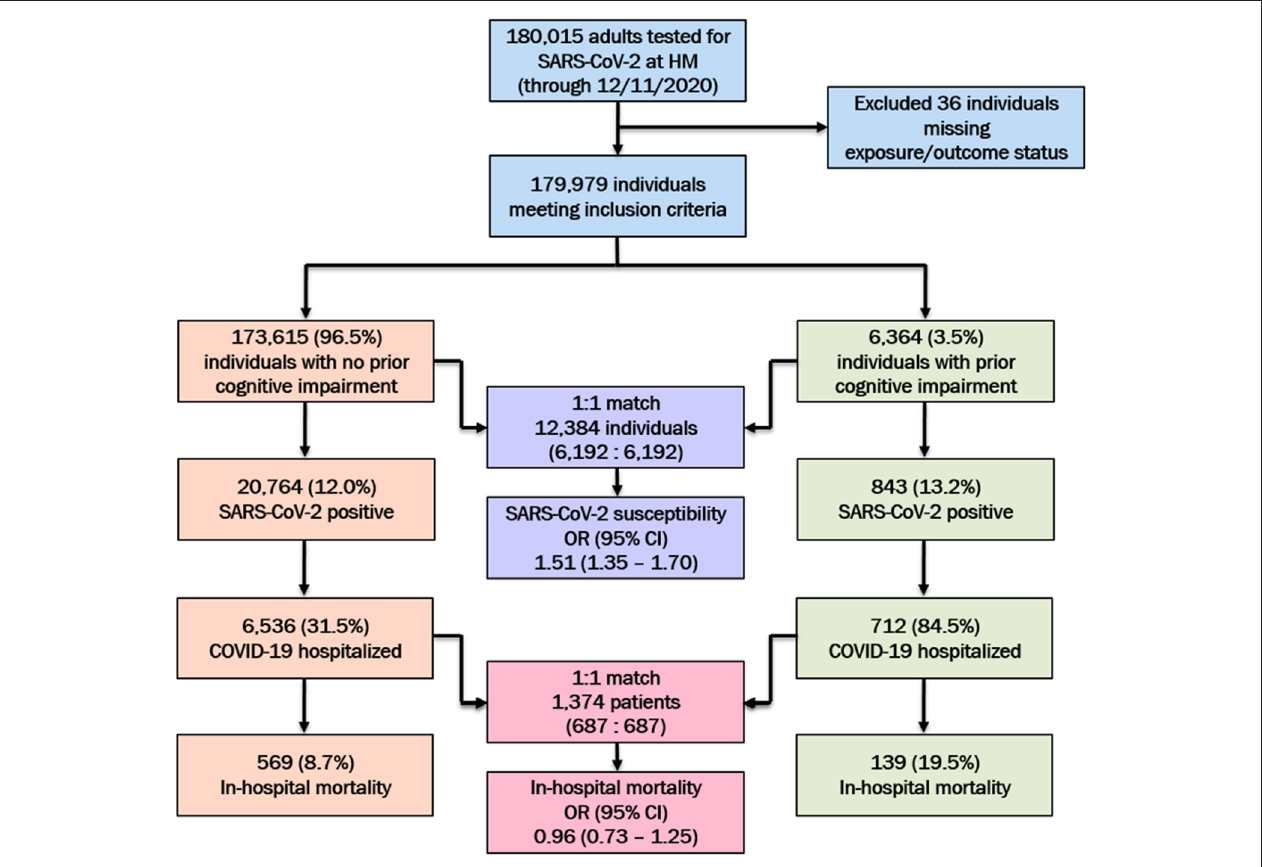
FIGURE 1 | SARS-CoV-2 testing characteristics and hospital outcomes among the study population at Houston Methodist (HM), stratified by preexisting cognitive impairment status. Post-propensity score matched odds ratios (ORs) and 95% confidence intervals (95% CI) for SARS-CoV-2 susceptibility and in-hospital mortality among the cognitively impaired (vs. no cognitive impairment) population presented.